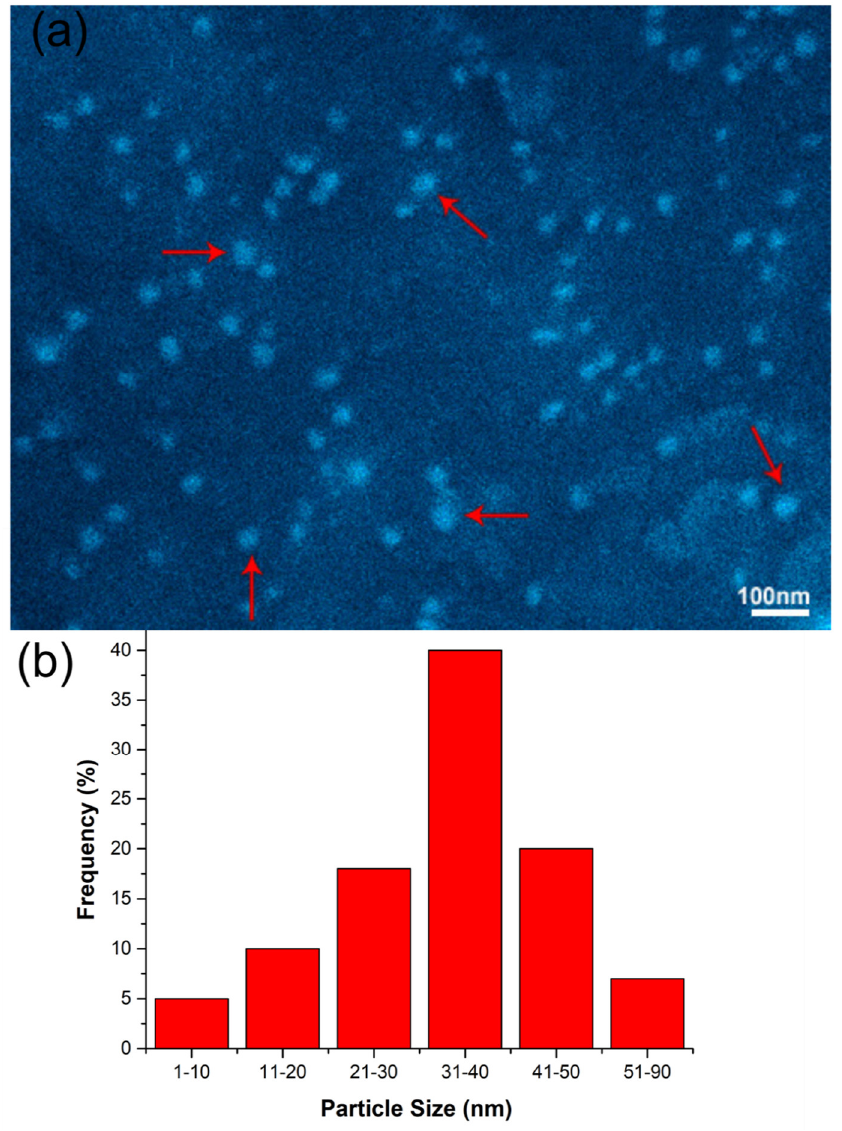
Figure 3. ( a ) SEM image of Ferene-S-AgNPs and ( b ) Particle-size distribution histogram of Ferene-S-AgNPs.